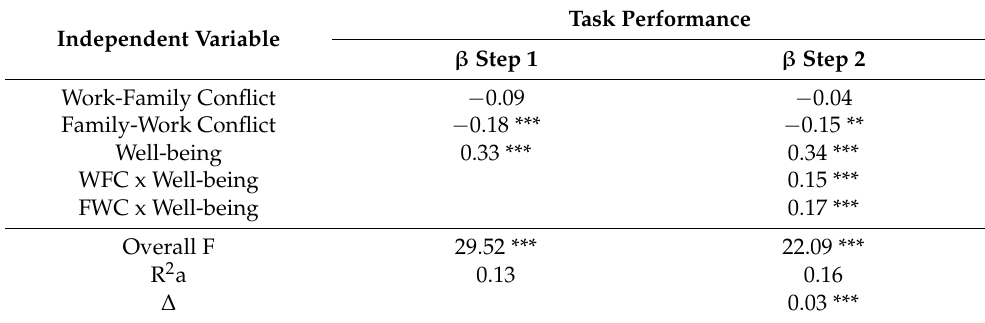
Table 7. Results of the moderation effect